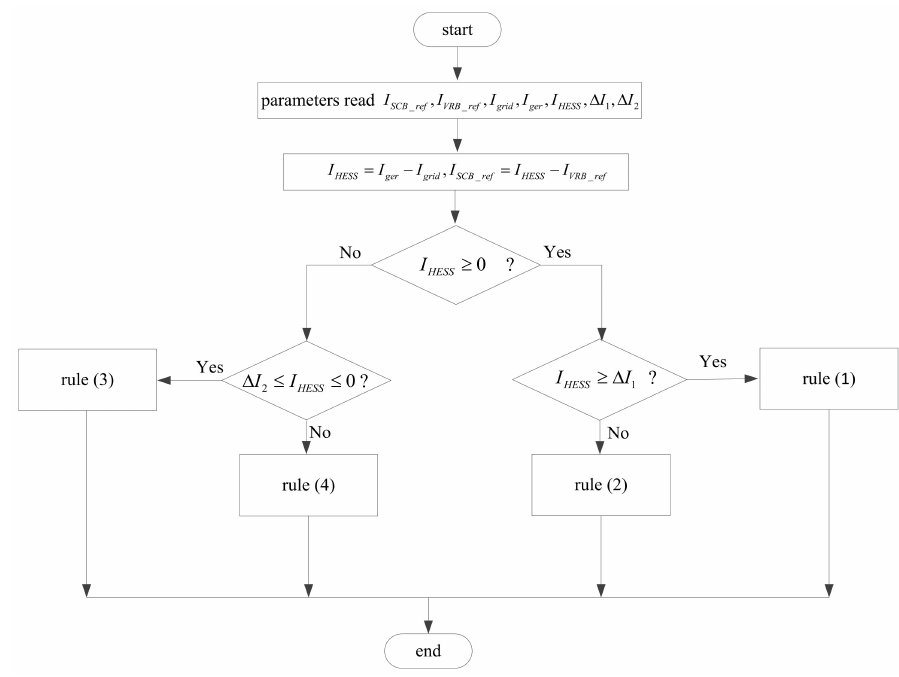
Figure 11. Internal control structure of rule-based control